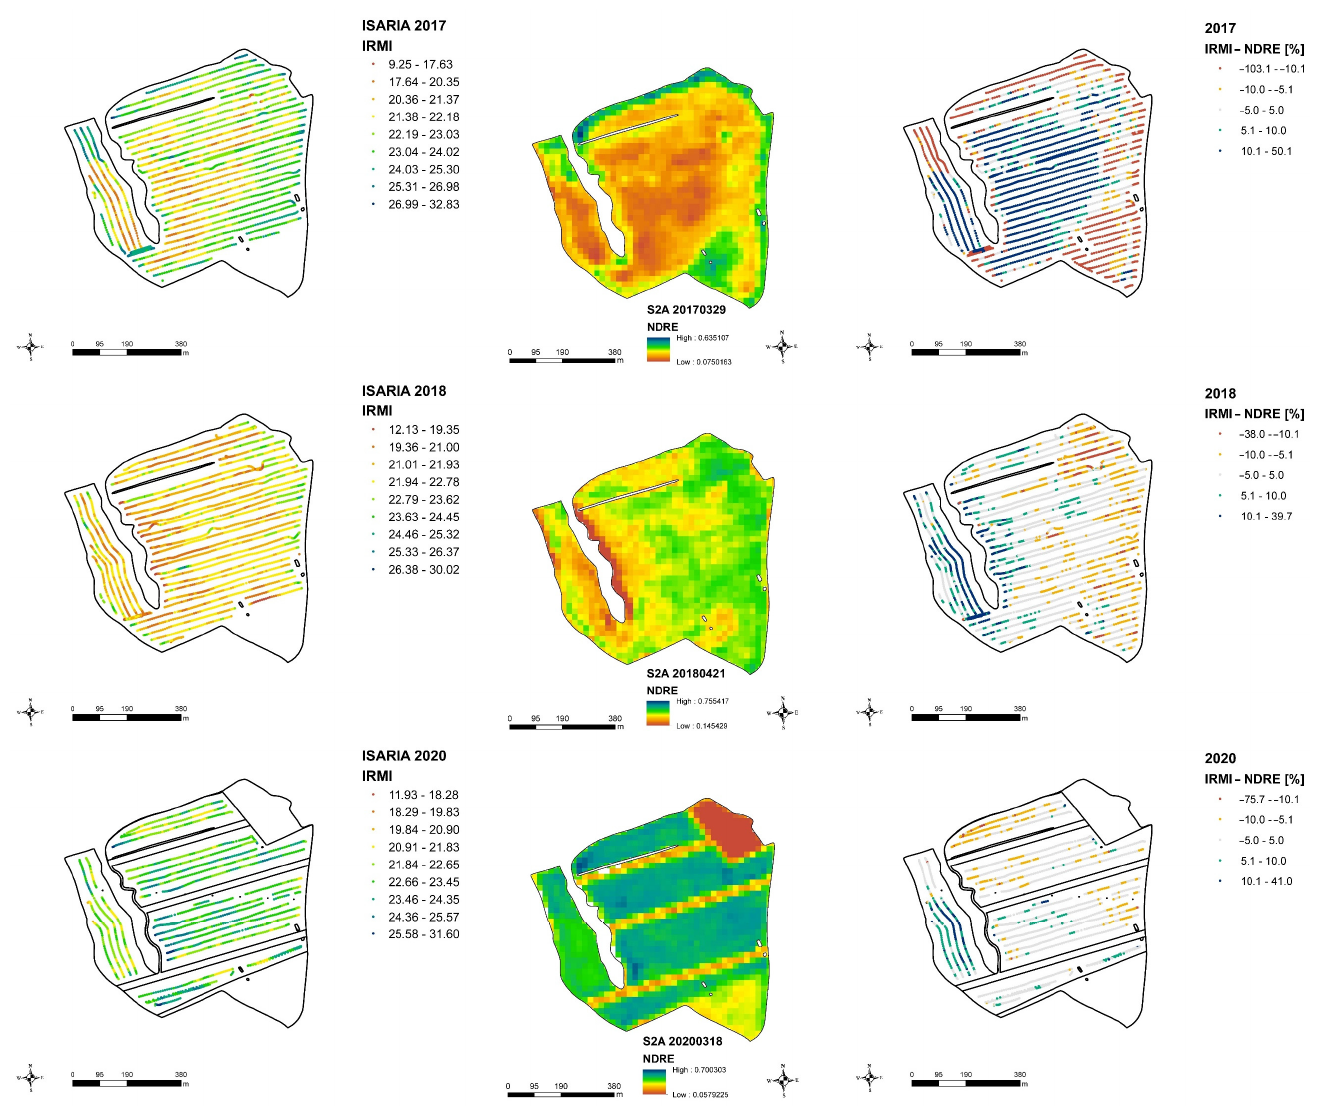
Figure A4. Example of the comparison of proximal and remote sensing on experimental field ID 3202_1 in the selected years: vegetation index ISARIA IRMI ( left ); vegetation index Sentinel-2 ( middle ); relative (%) comparison of differences between the two sensing systems ( right